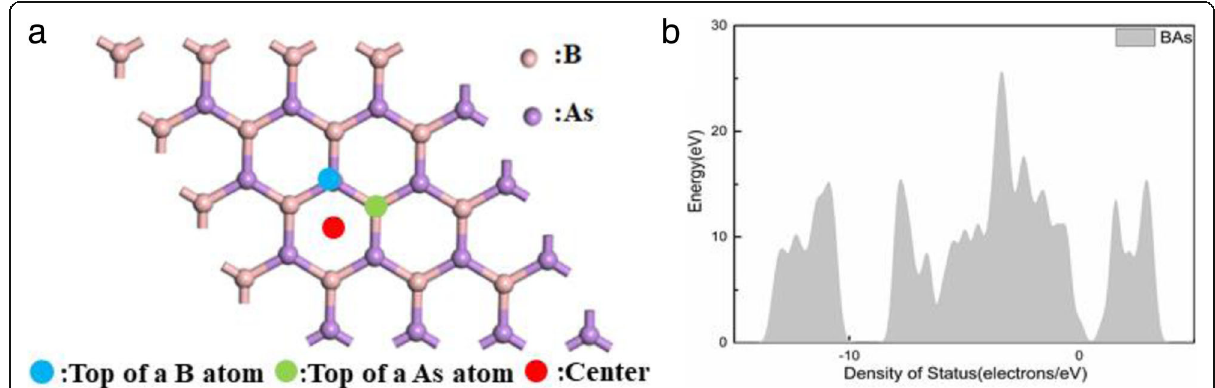
Fig. 1 a Schematic view of top sites and center site on BAs. b The DOS of the